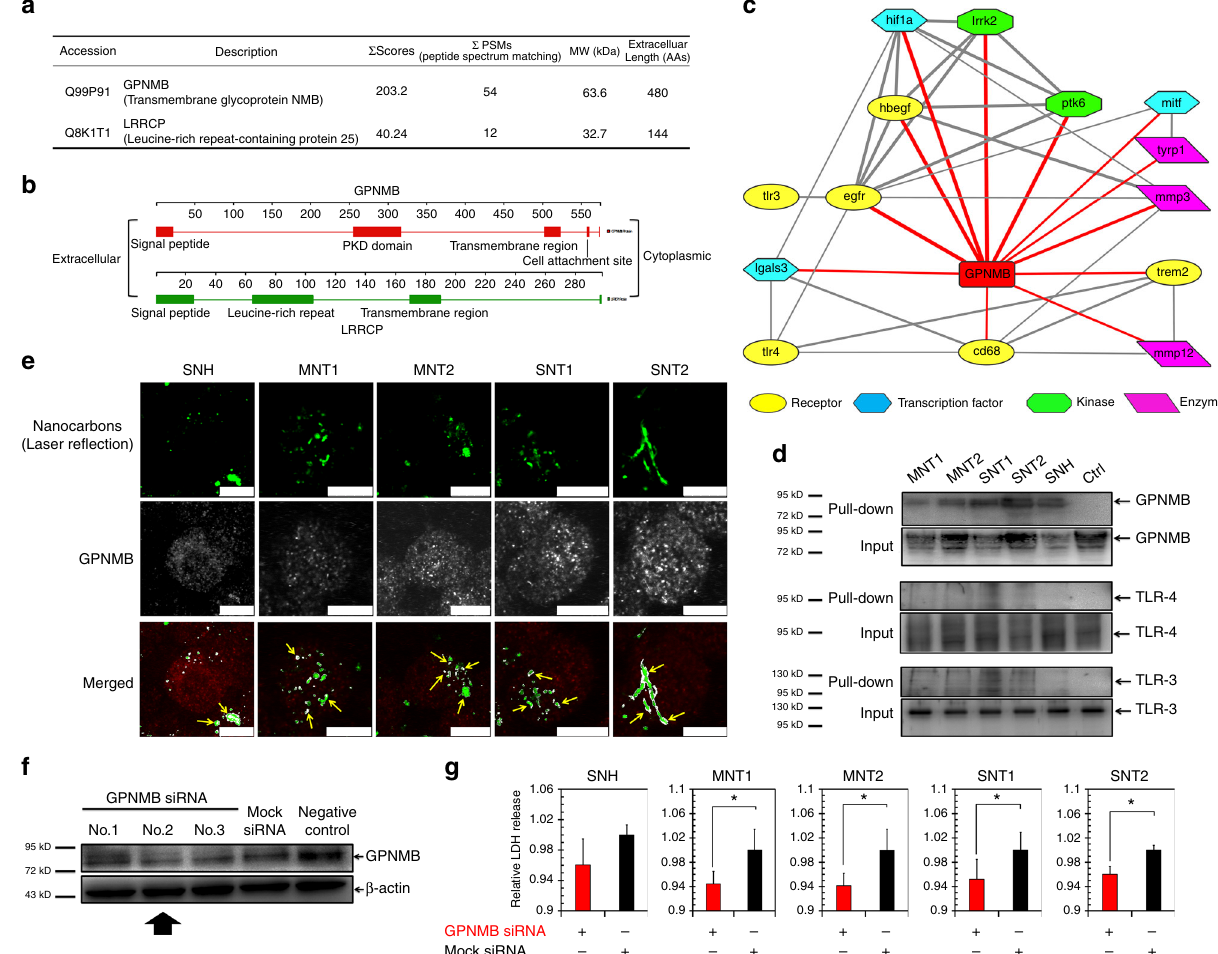
Fig. 9 SNH triggered less GPNMB-regulated cell death. a The brief illustration of properties of two identi fi ed transmembrane proteins, GPNMB and LRRCP. b Schematic of topology and structure domain analysis of GPNMB and LRRCP. c Protein – protein interaction network centered with GPNMB detected by STRING software. The direct interactions with GPNMB were exhibited with red color. The thickness of bond represented the strength of interaction. d “ Pull down ” assay of GPNMB, TLR-3 and TLR-4 proteins based on immunoprecipitation-like strategy after nanocarbon incubations. GPNMB showed higher af fi nity with nanocarbons than Toll-like receptors. e Co-localization images of intracellular nanocarbons with GPNMB proteins detected by CLSM. Yellow arrows and white colors denoted the co-localization regions. Scale bar: 10 μ m. f Western blot analysis of GPNMB expression after targeted GPNMB siRNA transfections with different sequences. As shown by black arrow, No.2 exhibited the greatest silence effect and was selected for subsequent cytotoxic test. g Cytotoxicity detections of different nanocarbons after GPNMB knockdown via LDH release assay ( n = 3). Data were presented as mean ± s.d. Statistical signi fi cances were calculated by Student ’ s t -test: * p <